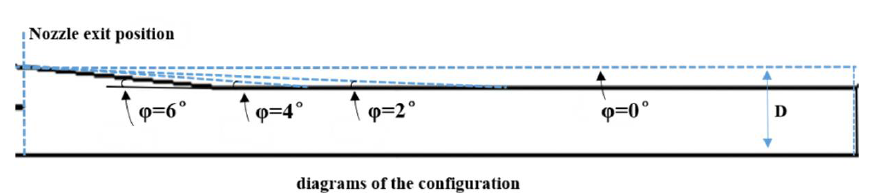
Figure 2. Configuration diagrams for Cases 1~4.